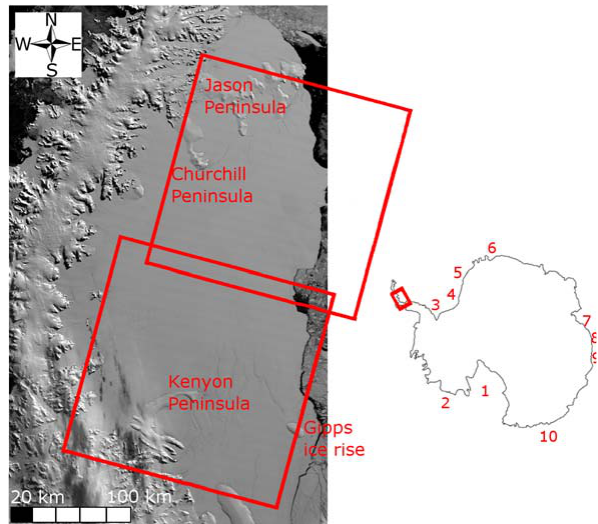
Fig. 1. Sketch map over Antarctica (right) and image of Larsen C ice shelf (left). The position of the MODIS image is indicated as red rectangle in the right panel and it forms the background in the left panel. The position of the Landsat validation images are indi- cated in red in the left panel (path 216 row 108 and path 216 row 107). The numbers mark the locations of the other ice shelves in- vestigated: 1. Ross, 2. Getz east, 3. Ronne, 4. Filchner, 5. Riiser- Larsen, 6. Fimbul, 7. Amery, 8. West, 9. Shackleton, 10. Mertz. The MODIS image is from 2002 and was preprocessed by Scambos et al.